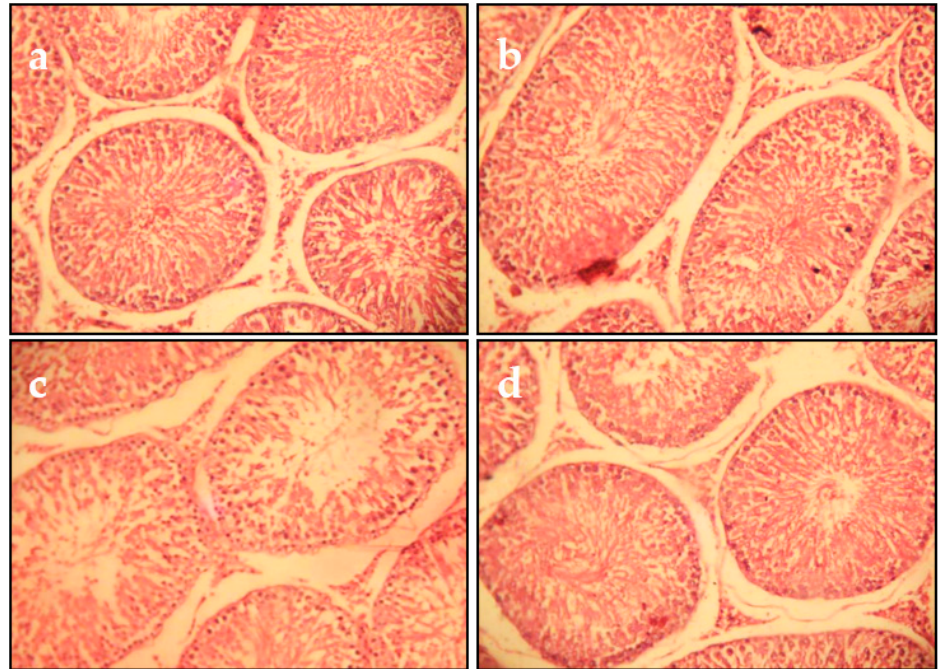
Figure 6. Microscopic evaluation of testicular tissue from juice extract of O. stricta alone, Cd and juice co-treated groups at 5 weeks (H&E 400): ( a ) Control group. ( b ) Juice extract (250 mg/kg)-treated group showing that the seminiferous tubular cells and interstitial tissue were normal. ( c ) Section of testes from rats treated with Cd (1 mg/kg, for 5 weeks); interstitial tissues showed edema, hemorrhage, and vacuolation, and seminiferous tubules were edematous with intact germinal layer and undergoing degeneration along with loss of spermatogenesis. ( d ) Section of testes from rats treated with Cd (5 weeks) and juice extract of O. stricta (250 mg/kg).